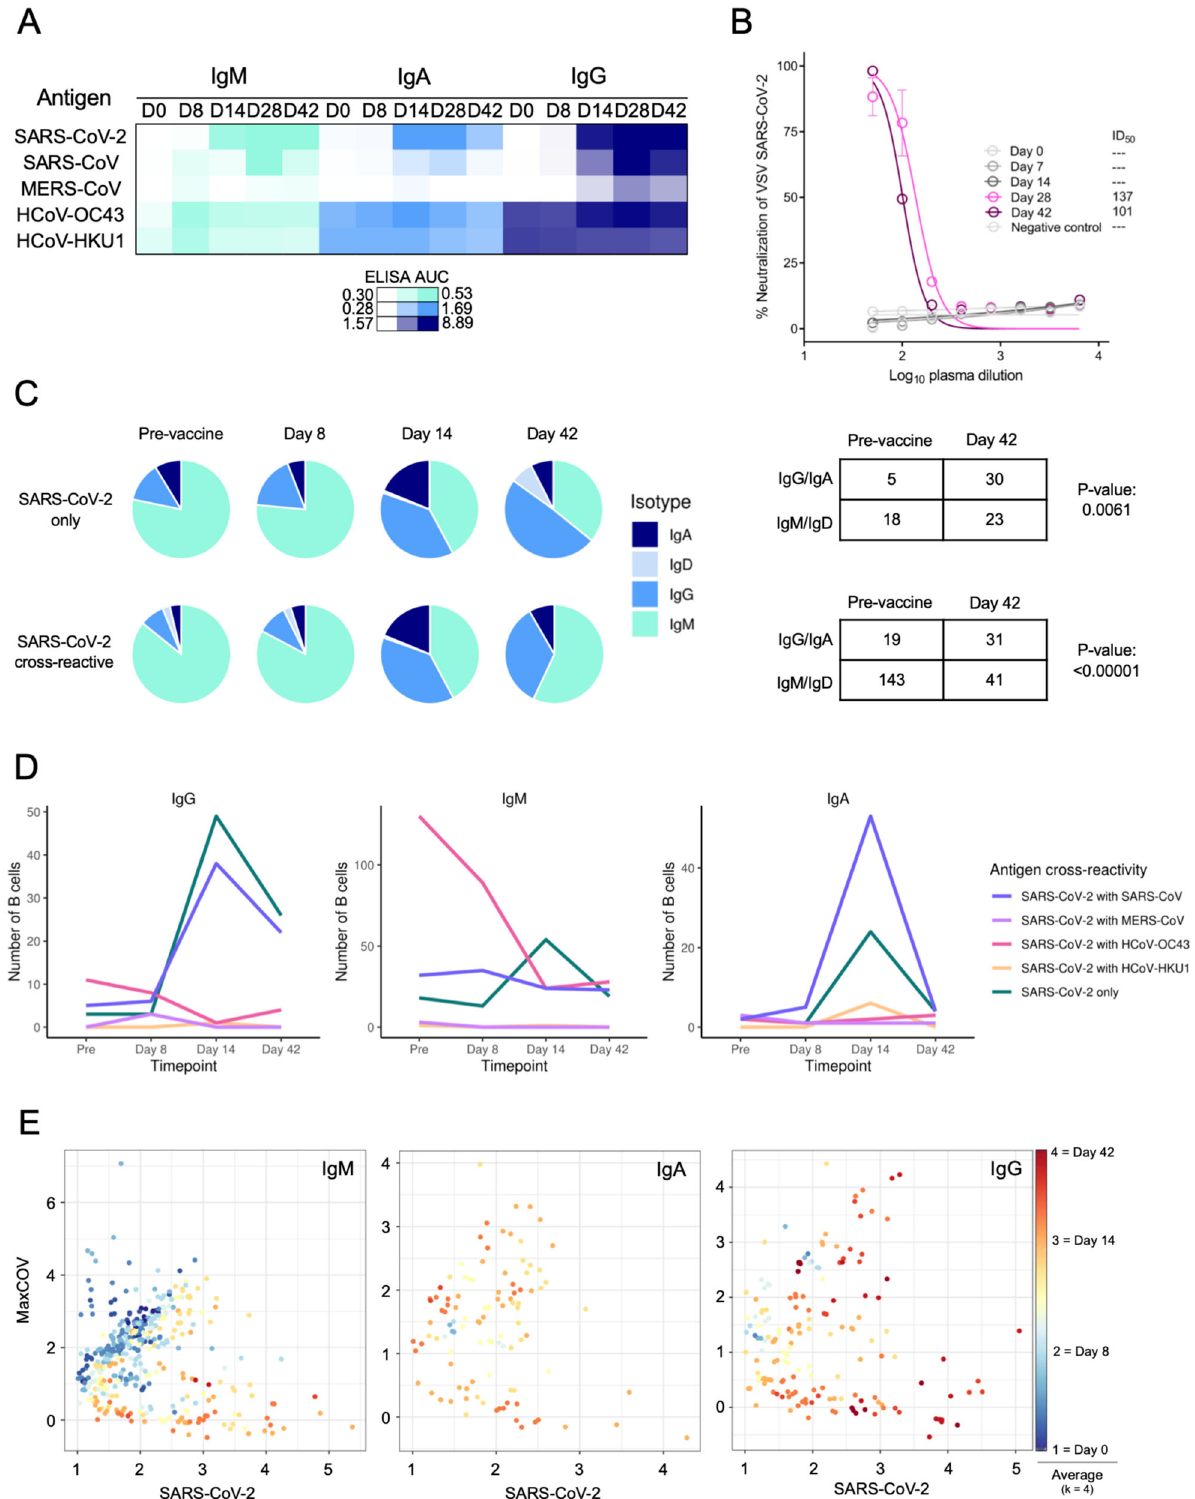
cells 76,77 or activation of Toll-like receptor 7 (TLR7) on dendritic cells 78 . Indeed, the addition of a single-stranded RNA adjuvant to a traditional in fl uenza vaccine generated mucosal immunity through a robust IgA response and provided more strain cross- protection 79